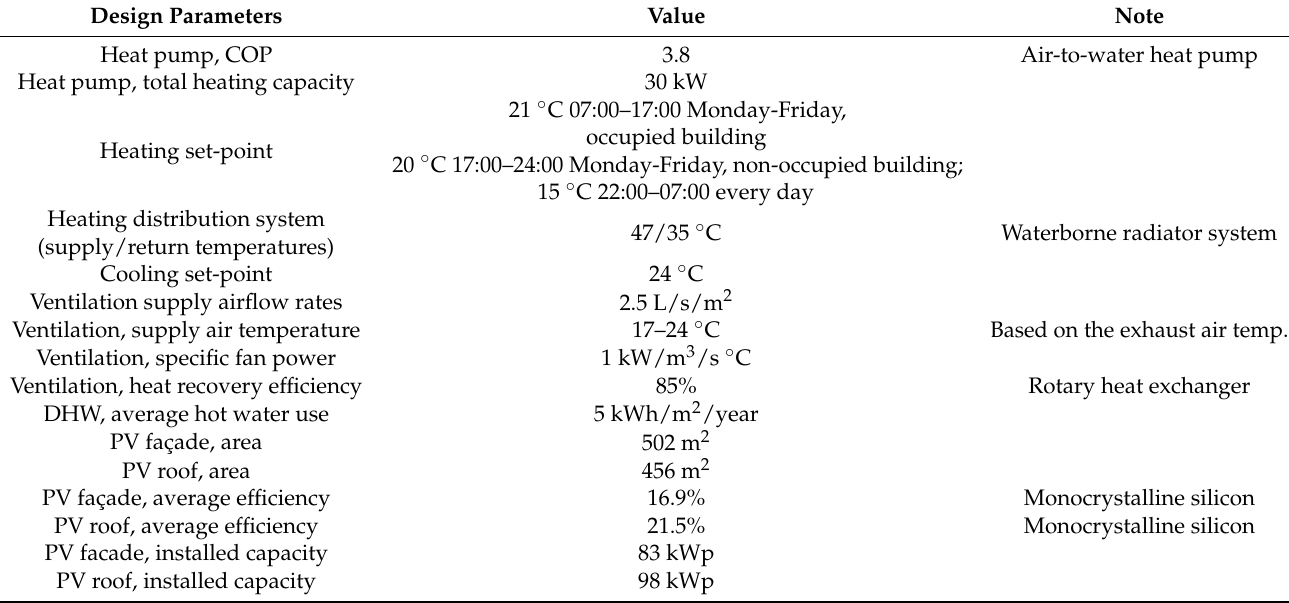
Table A4. Main building systems’ parameters for the case study